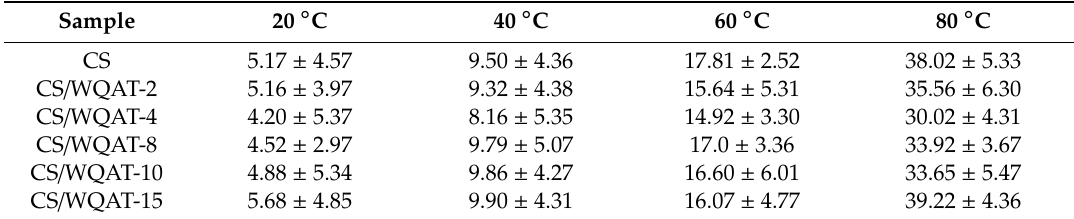
Table 3. Area swelling ratio (%) of the composite